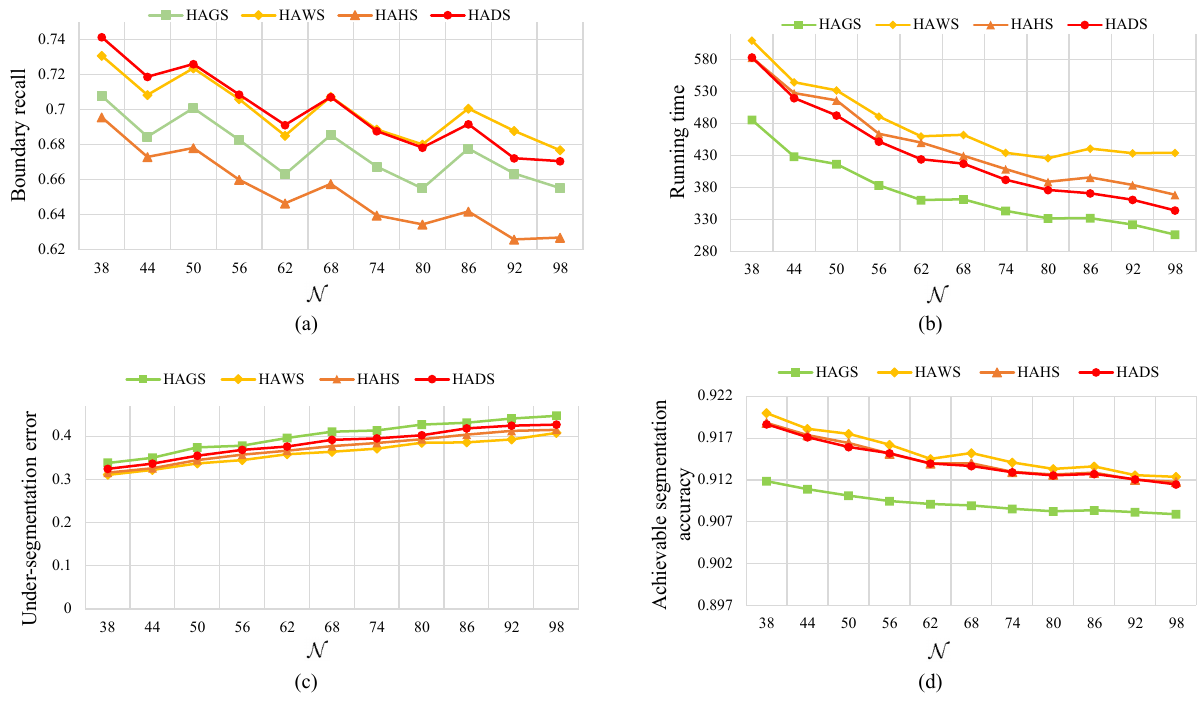
Figure 17. Quantitative evaluation results based on data set 1. ( a ) BR. ( b ) RT(s). ( c ) USE. ( d ) ASA.